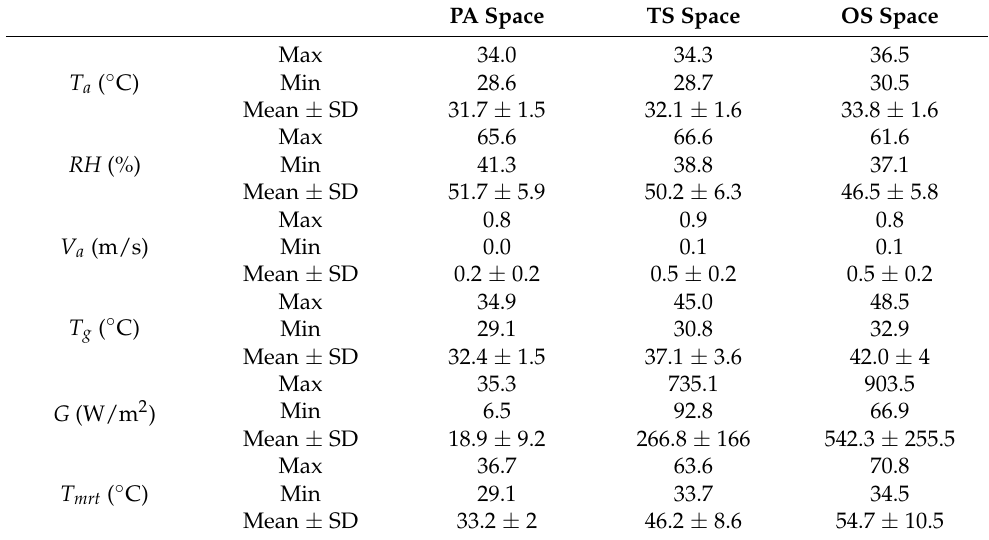
Table 5. Meteorological variables among spaces.